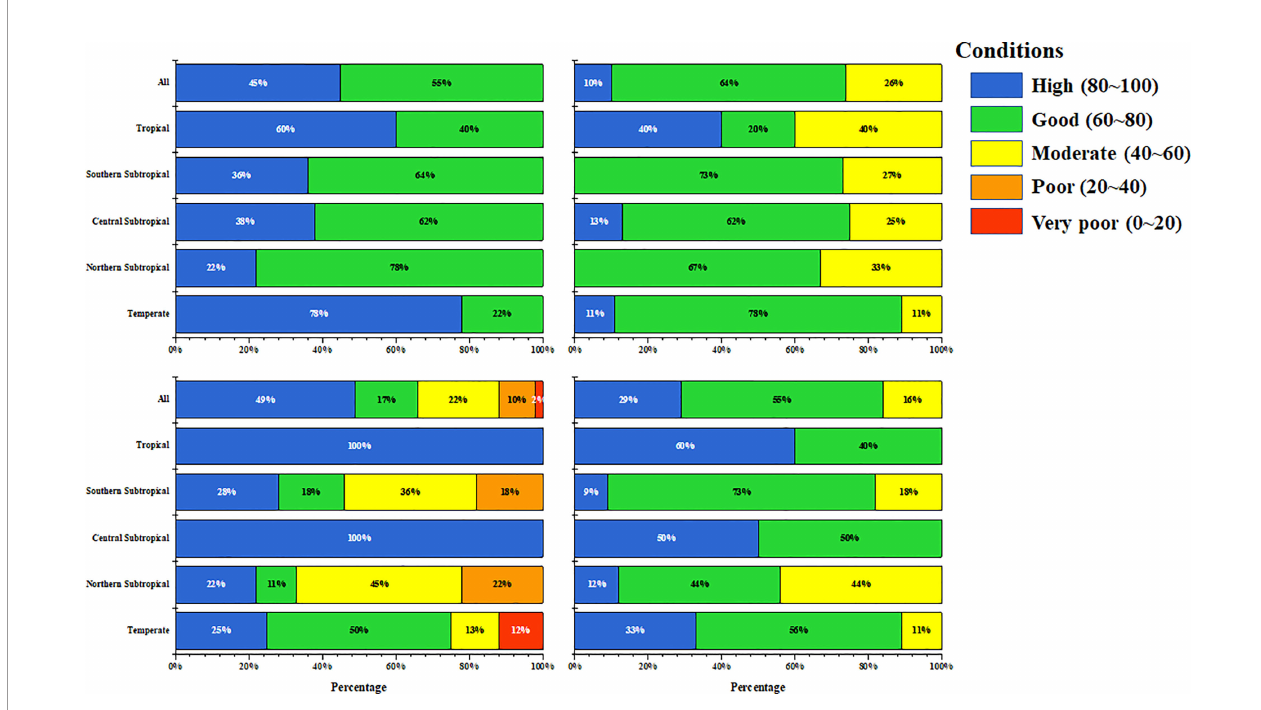
FIGURE 3 | Integrated assessment results of island ecosystem (a: I env , b: I bio , c: I land , d: CI land ).